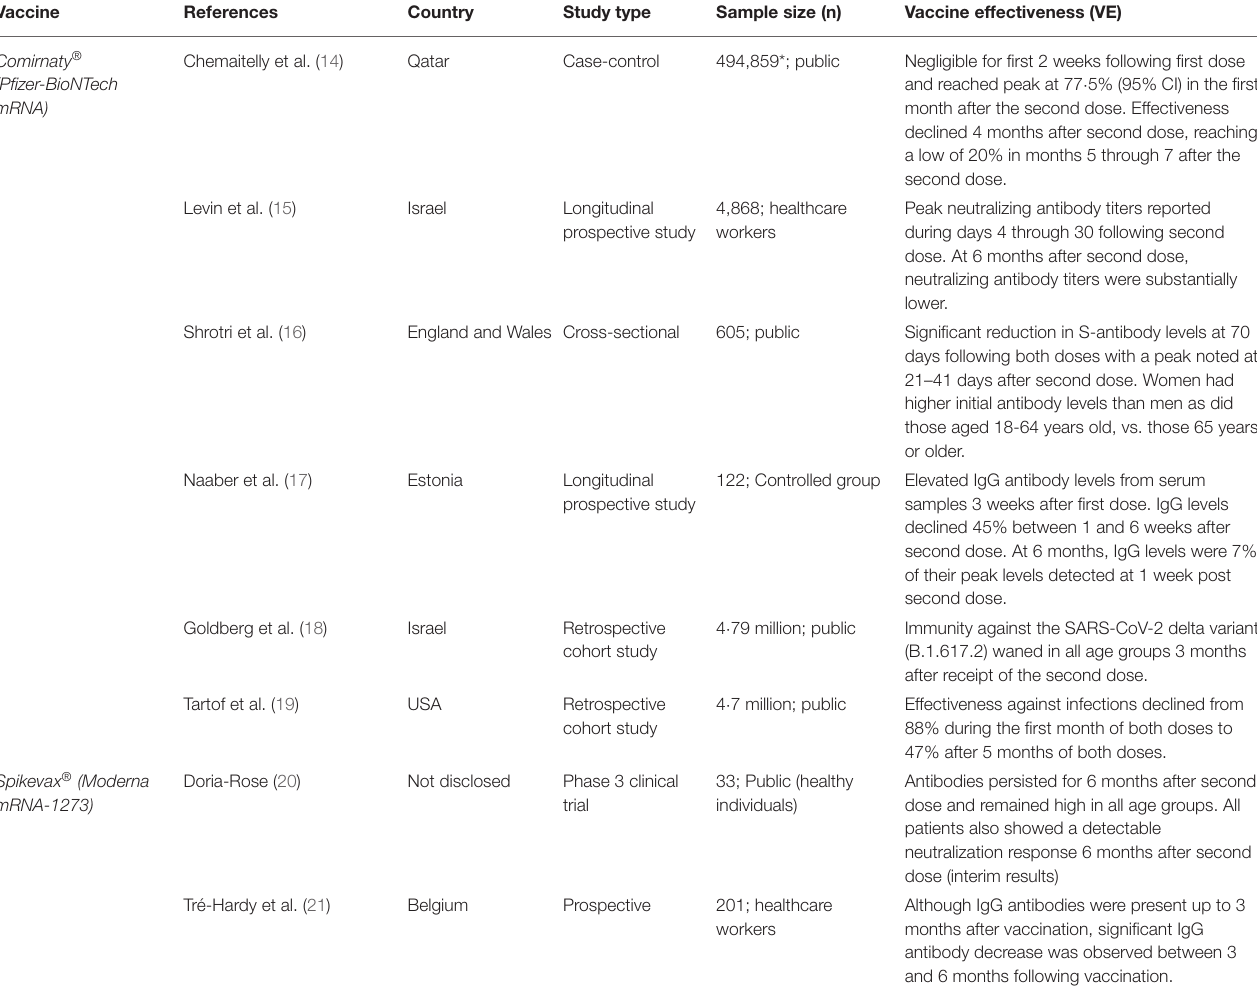
TABLE 1 | Summary of current literature detailing the durability of available SARS-CoV-2 mRNA vaccines and their efficacy offered over time for fully vaccinated individuals.